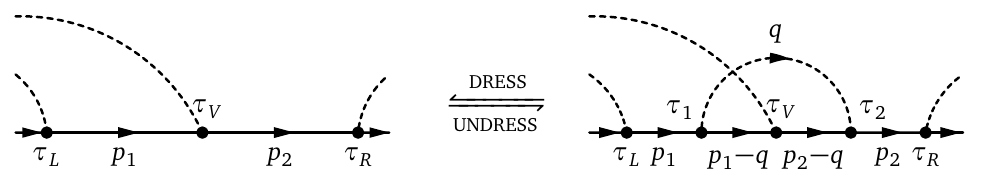
Figure 23: Illustration of the VERTEX-DRESS / VERTEX-UNDRESS pair of